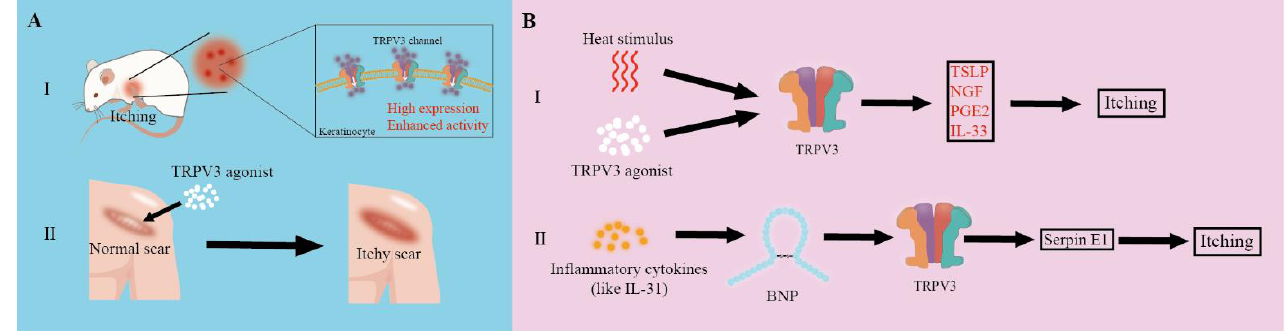
Figure 2. ( A ) Evidence of TRPV3-mediated itching. ( I ) High expression and enhanced activity of the TRPV3 channel was found in itchy skin. ( II ) After treatment with TRPV3 agonist, the normal scar became itchy. ( B ) The mechanism of TRPV3-mediated itching. ( I ) After activation by heat stimulus or a TRPV3 agonist, activated TRPV3 provoked itching through thymic stromal lymphopoietin (TSLP), nerve growth factor (NGF), prostaglandin E2 receptor EP3 subtype-like (PGE2), and IL-33. ( II ) Inflammatory factors such as IL-31 induce high expression of B-type natriuretic peptide (BNP) to activate TRPV3, which leads to the upregulation of Serpin E1 and